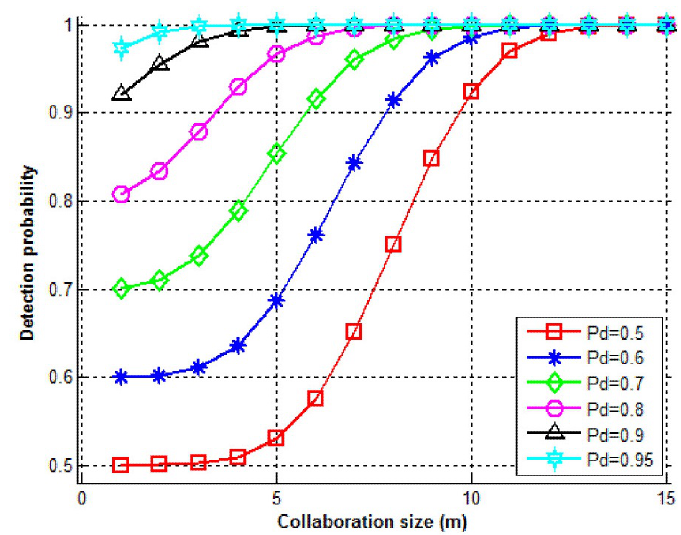
Figure 15. Detection probability ( P